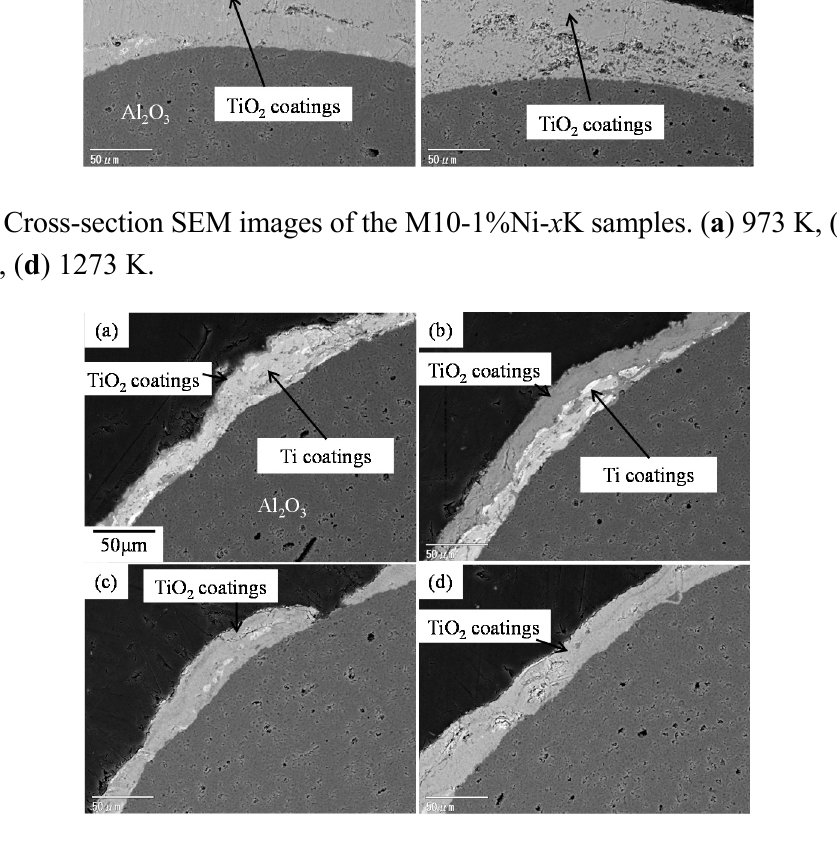
Figure 46. Cross-section SEM images of the M10-5%Ni- x K samples. ( a ) 973 K, ( b ) 1073 K, ( c ) 1173 K, ( d ) 1273